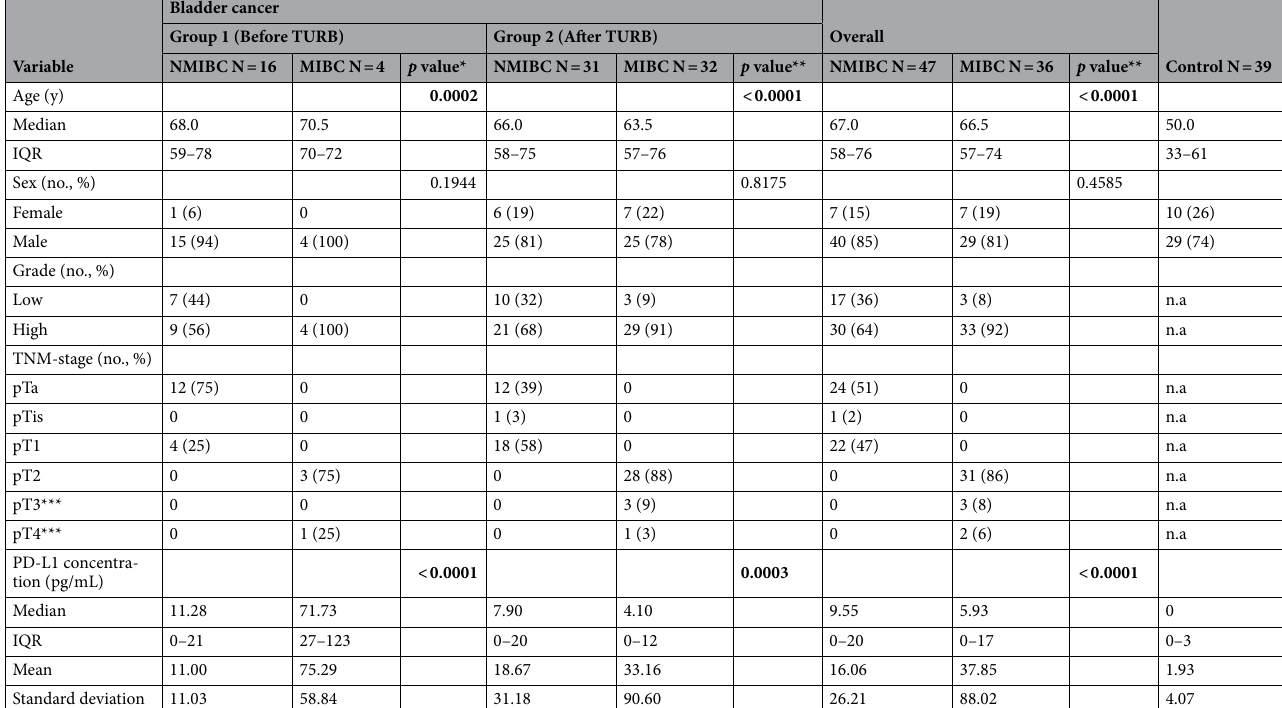
Table 1. Baseline clinical and pathological features of healthy controls and patients with bladder cancer along with urinary levels of PD-L1. Abbreviations IQR: inter-quartile range; n.a.: not applicable; NMIBC: non-muscle invasive bladder cancer; MIBC: muscle-invasive bladder cancer; TNM: tumor, node, metastasis (classification); TURB: transurethral resection of the bladder. *Kruskal–Wallis and Fisher’s exact test used to determine if there was significant variation in the medians of the control and NMBIC and MIBC groups for continuous (age and PD-L1 concentration) and categorical variables (sex), respectively. **Kruskal–Wallis and